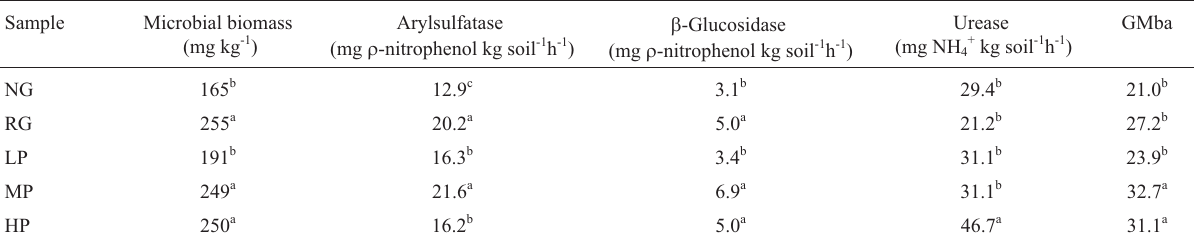
Table 2 - Biochemical characteristics of the soil under different grazing